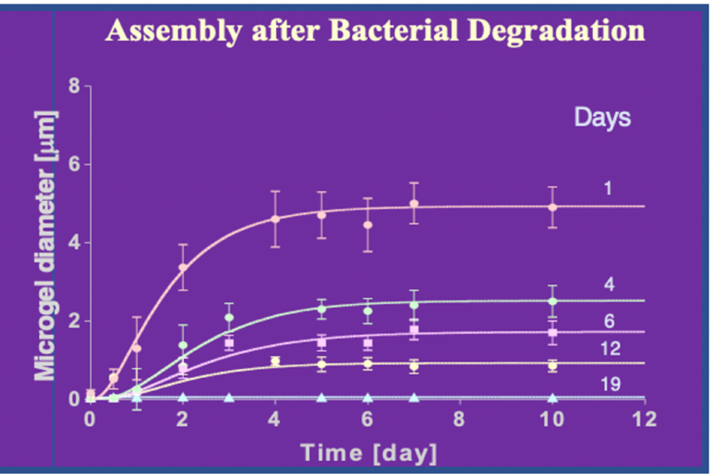
Figure 29. Bacterial cleavage of DOM results in progressive compromise of MBP self-assembly. The protocol for these assays is described above. Data points correspond to the mean ± S.D of 18 DSL